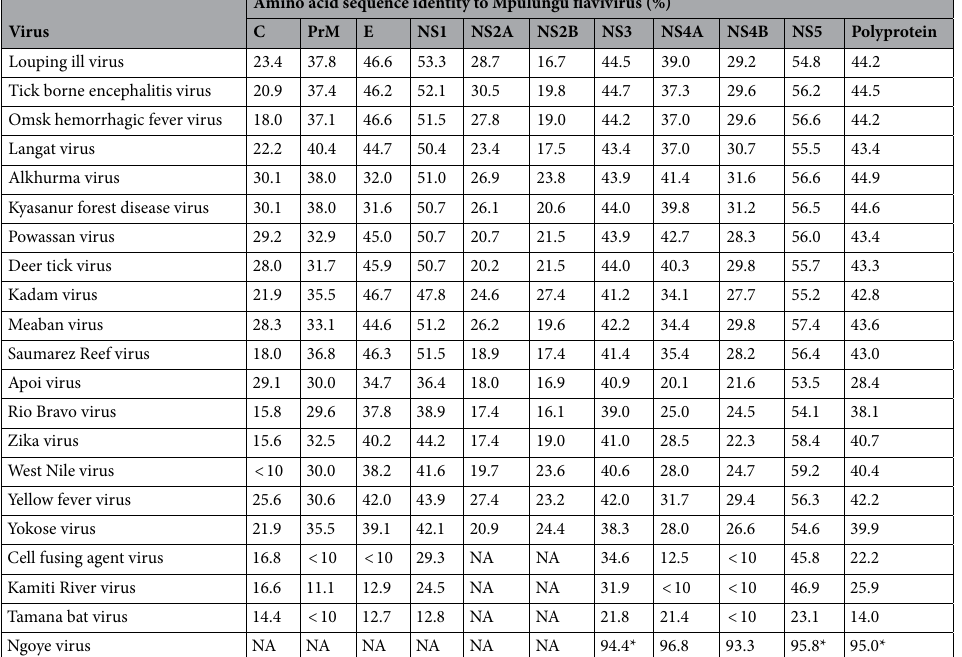
Table 2. Identity comparison of encoded proteins between Mpulungu flavivirus and other flaviviruses. CTHD and 2K protein sequences were not analyzed. *Partial amino acid sequences were used for analyses. NA not